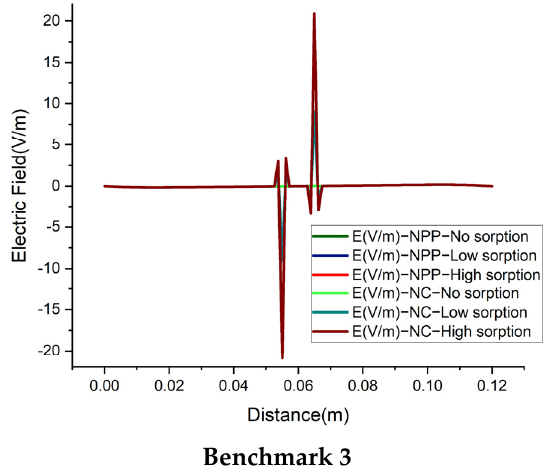
Figure 10. The electric field for the 1D benchmarks with the NPP and NC-models.